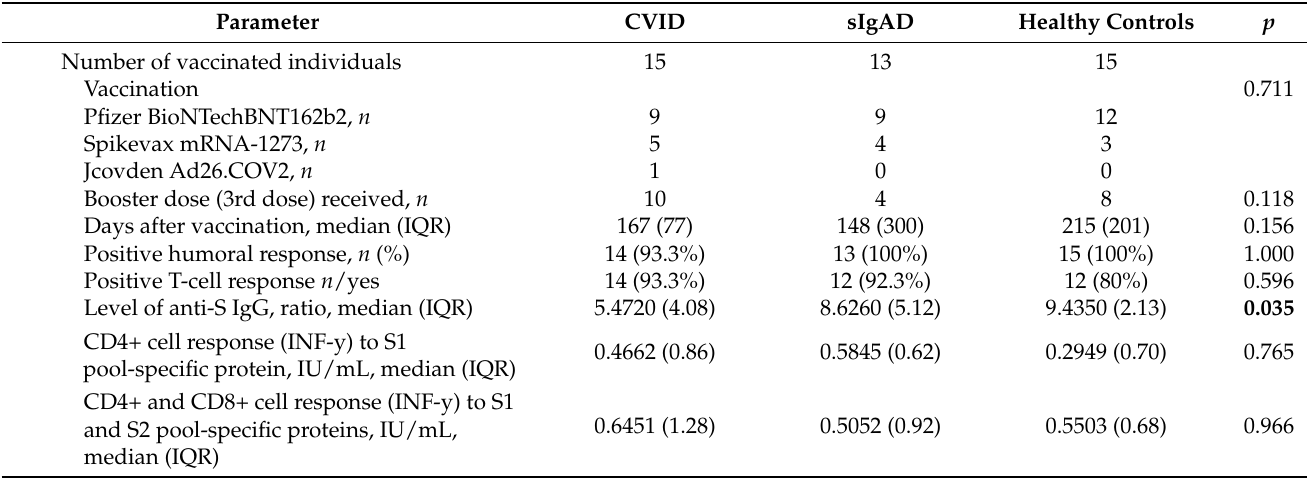
Table 2. Vaccination-related parameters in patients and